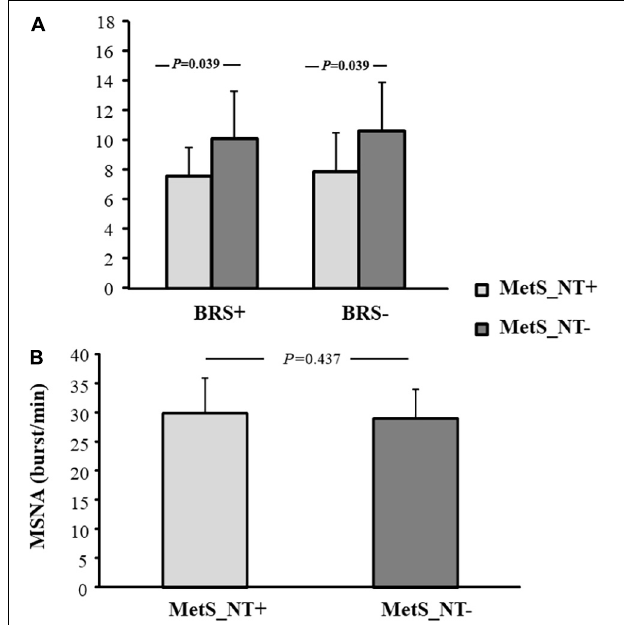
FIGURE 4 | Baroreflex sensitivity for increases (BRS+) and decreases (BRS − ) in spontaneous BP fluctuations (A) , and muscle sympathetic nerve activity [MSNA, (B) ] in normotensive MetS patients who presented EEBP during maximal CPET (MetS_NT+, n = 10) and in normotensive MetS patients without EEBP during CPET ( MetS_NT − , n =